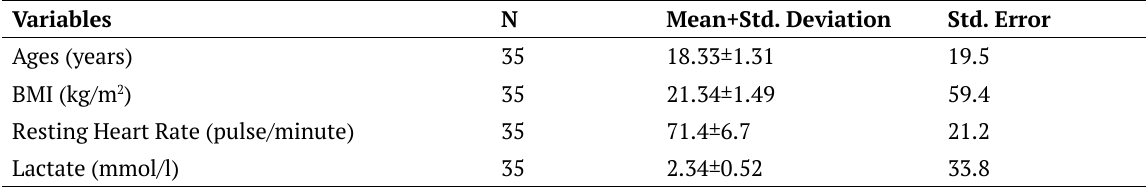
Table 1. The characteristic of Ages, BMI, Pulse rate and Lactate